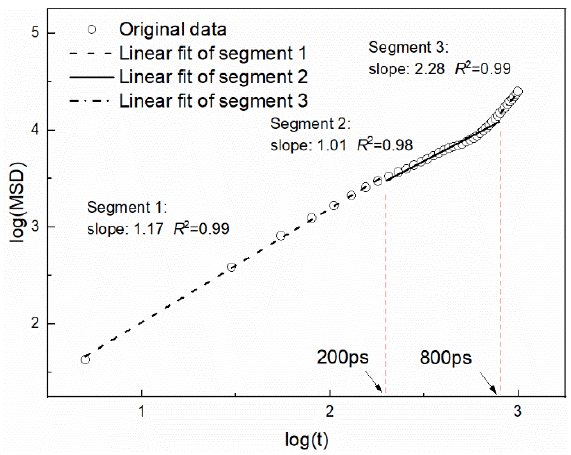
Figure 10. MSD of naphthalene on kaolinite (alumina octahedral surface)/water interface (log( MSD ) vs. log( t )) under the water film of 15 Å . Table 3. Interaction energy ( E 1/2 ) and self-diffusion coefficients ( D ) of naphthalene on kaolinite/wa- ter surface.